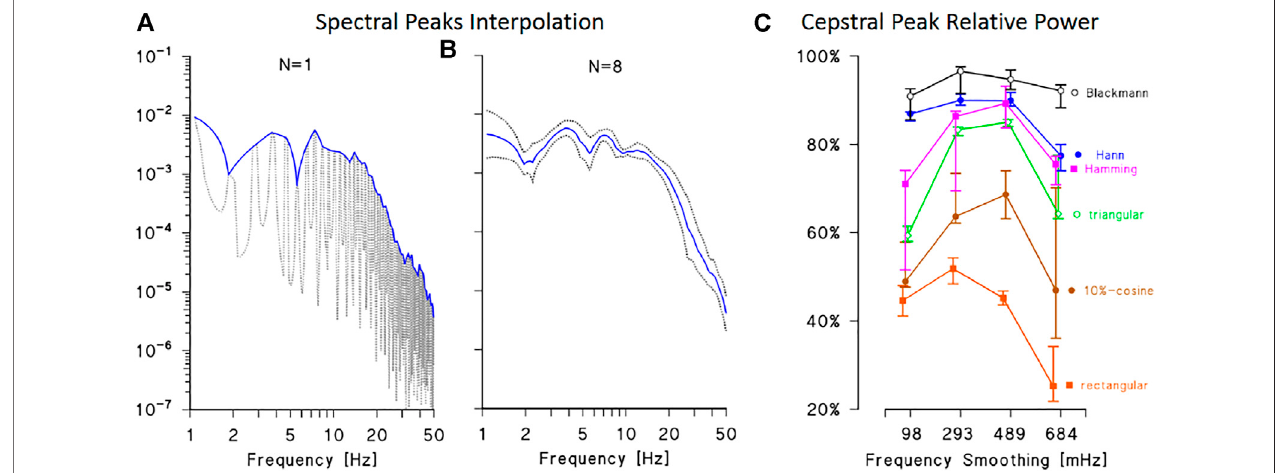
FIGURE 2 | De fi nition of data windows for ECG cepstral analysis. (A) : power spectrum of a synthesised ECG (dotted line) with interpolation of the maxima at the fundamental harmonic and its multiples (continuous line). (B) : average and 95% con fi dence interval of the lines interpolating the spectral maxima of 8 synthesised ECG. The average interpolating line is relatively constant up to 20 Hz and rapidly decreases at higher frequencies, suggesting to limit the length of the frequency-domain data windowupto20 Hz. (C) :relativepower ofthemain cepstral peak:medianand interquartilerange over8synthesised ECGs calculatedbysixdifferenttime-domain data windows and by smoothing the spectral lines using moving average fi lters with bandwidth between 98 and 684 mHz. The best performance is obtained with the Blackmann window and smoothing bandwidth between 250 and 500 mHz.